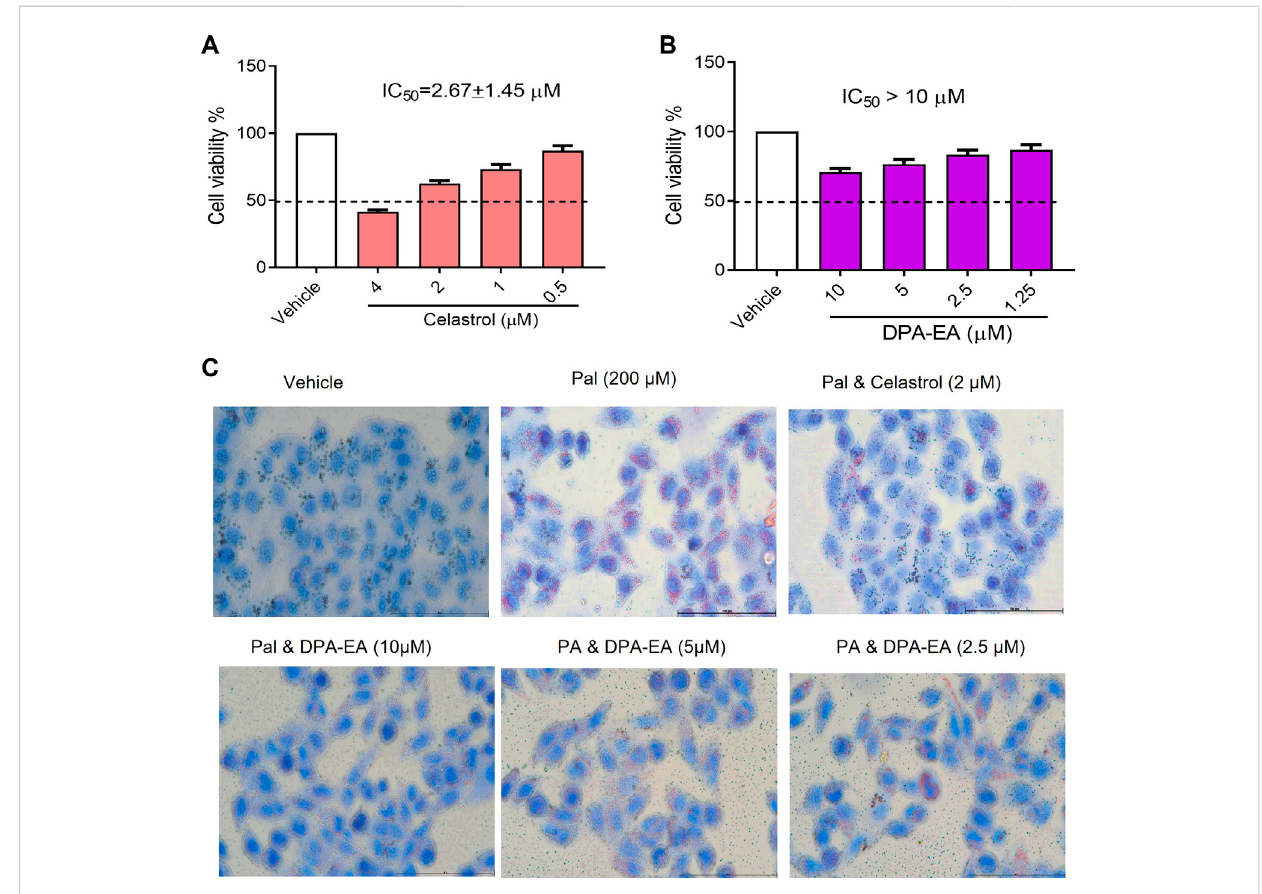
FIGURE 1 Effects of Celastrol and DPA-EA on cell viability and lipid droplets in HepG2 cells. (A) Effects of Celastrol at different concentrations (0.5, 1, 2, and 4 μ M)onthecellgrowthofHepG2. (B) EffectsofDPA-EAatdifferentconcentrations(1.25,2.5,5,and10 μ M)onthecellgrowthofHepG2cells. (C) Effects of DPA-EA and Celastrol at indicating concentrations on formation of lipid droplets in Pal-induced (200 μ M) HepG2 cells with Oil red staining assay. Images were captured with a microscope